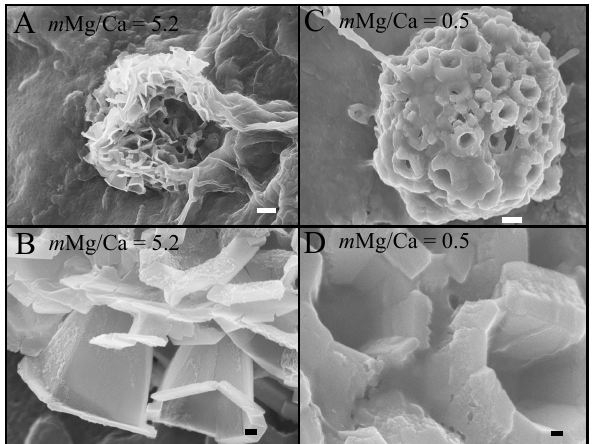
Backscatter electron images of the coccolithophore Ochrosphaera neopolitana after growth in experimental modern (Mg/Ca=5.2; A, B ) and Cretaceous (Mg/Ca=0.5; C, D ) seawaters. Coccoliths precipitated in experimental Cretaceous seawater appear to be larger and more heavily calcified than those precipitated in the modern seawater. White bars are 1µm; black bars are 100nm. From Stanley et al. (2005).